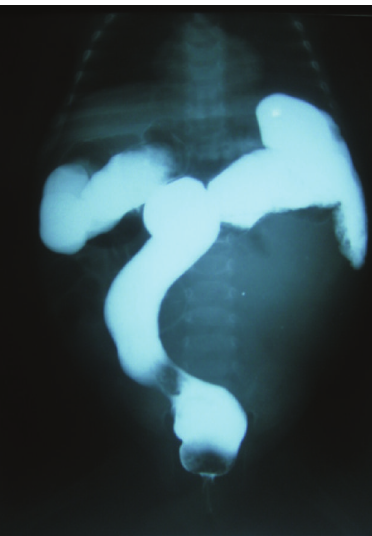
Figure 2: Barium enema showing smooth walled soft tissue shadow that is pushing the sigmoid upwards and to the right.